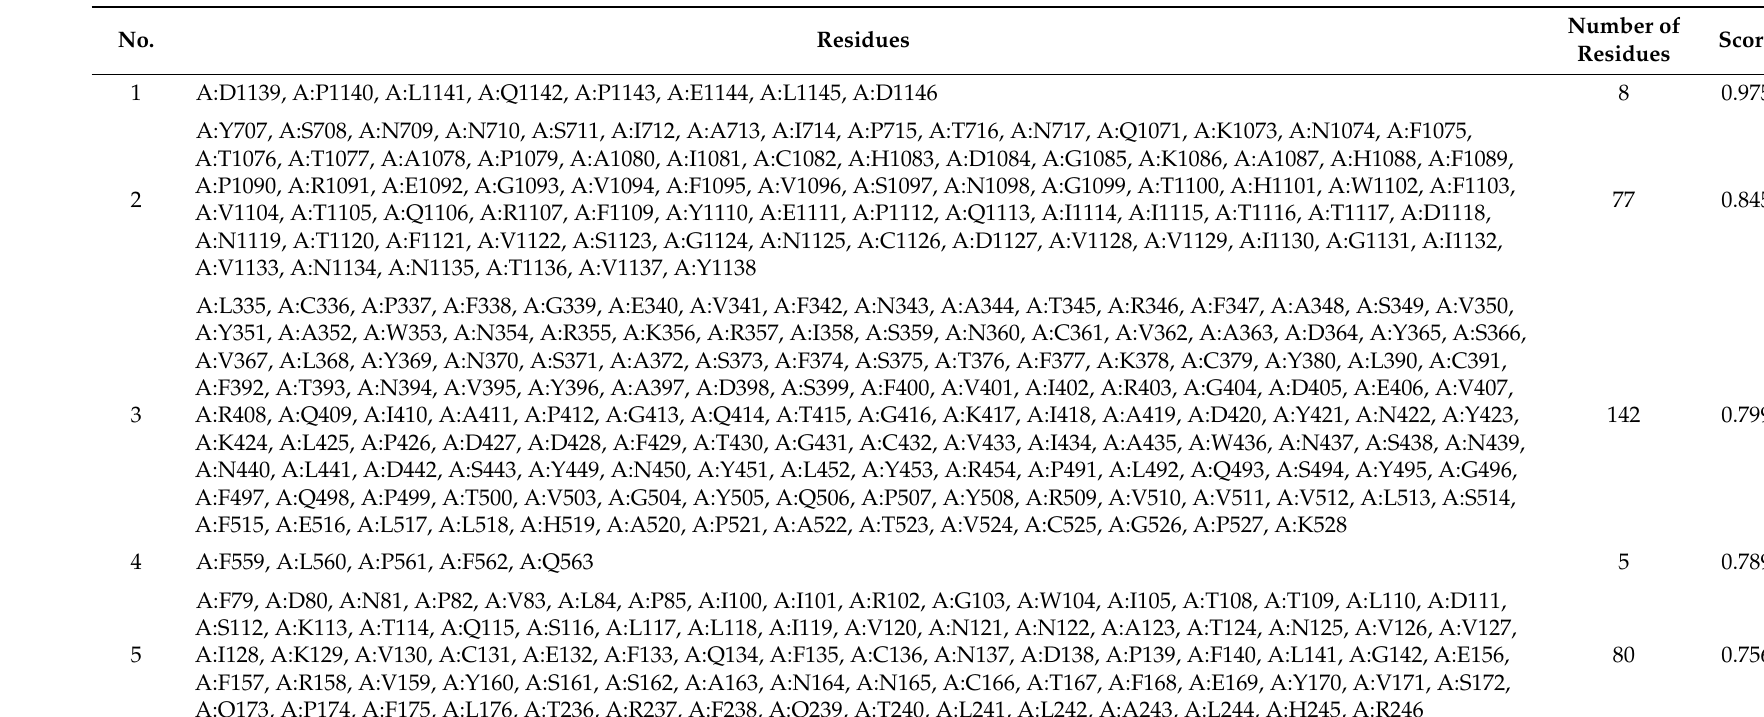
Table 11. Conformational epitopes from SARS-CoV-2 Nsp12